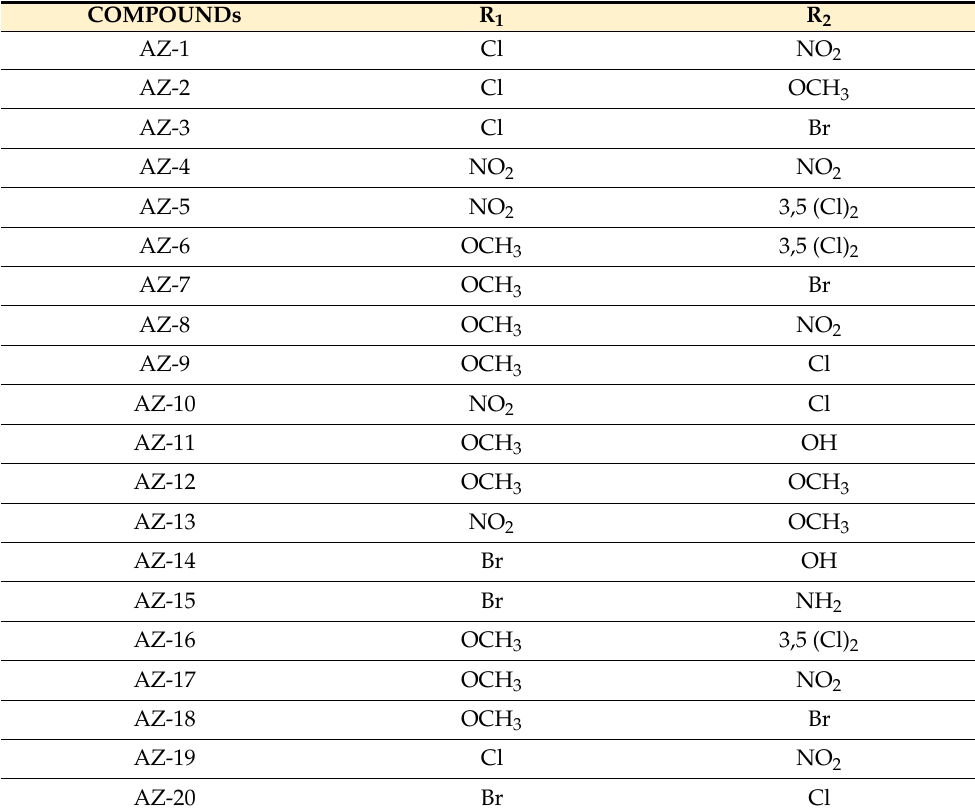
Table 1. Azetidin-2-one derivatives of 1,3,4-oxadiazole/thiadiazole ring.